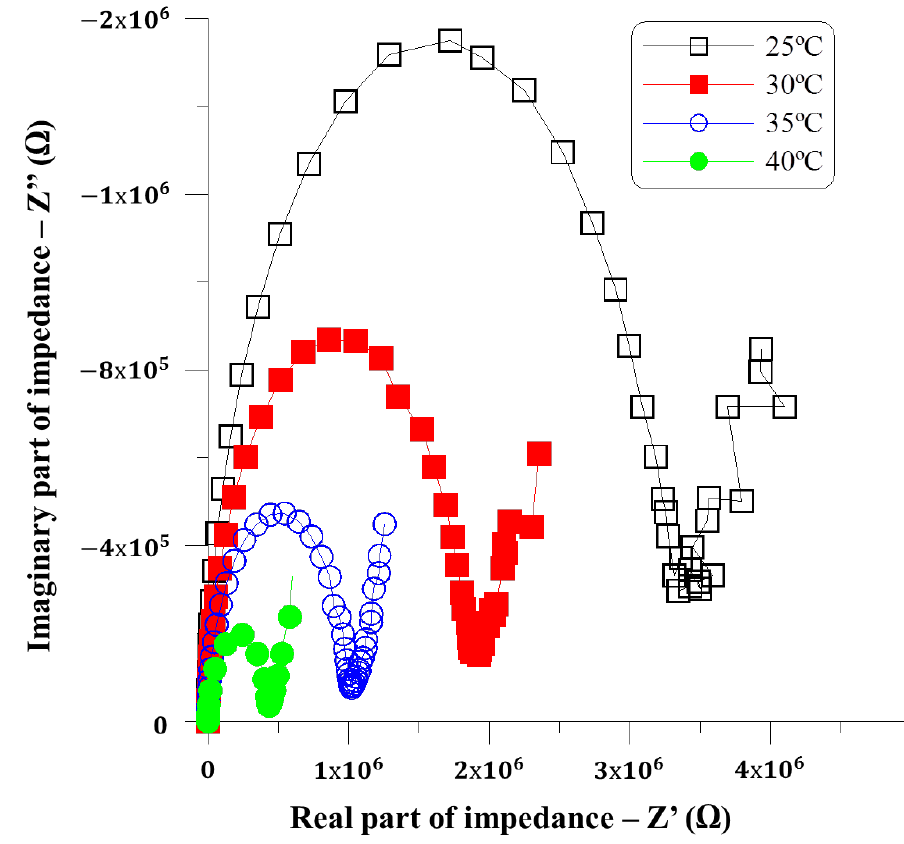
Figure 3. Impedance spectrum (Nyquist plot) for PDLC.